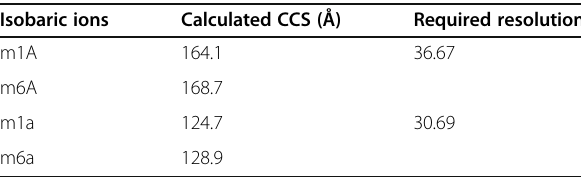
minimum resolution ( R ) that is required to resolve the peaks of selected isomeric ions in an ion mobility spectrum ( R = CCS/ Δ mobility spectrometry suite (IMoS) via the parallelized user interface (ParsIMoS) (Kune